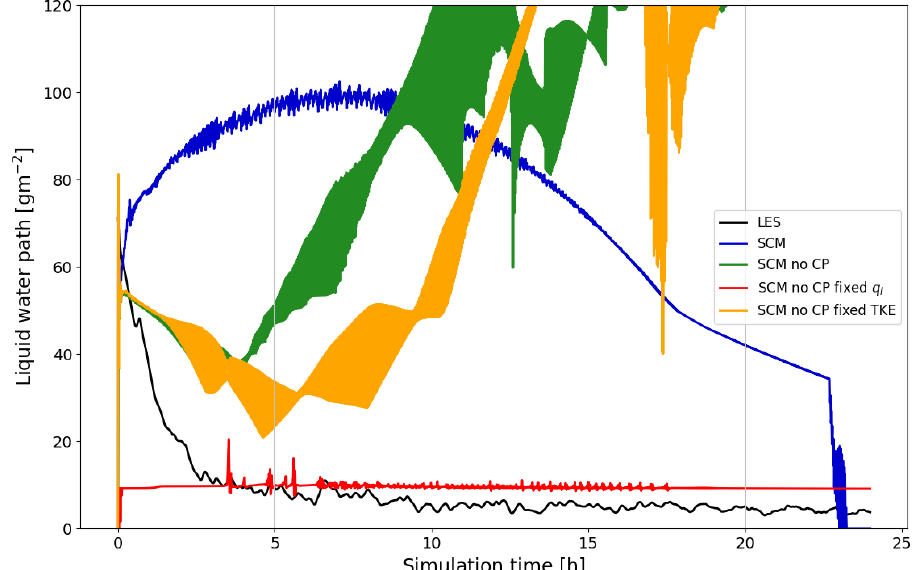
Figure 6. As in Figure 5, but for the temporal evolution of the liquid water path. It should be noted that the apparent shading of the green and the orange curve is the result of the high frequency oscillations.